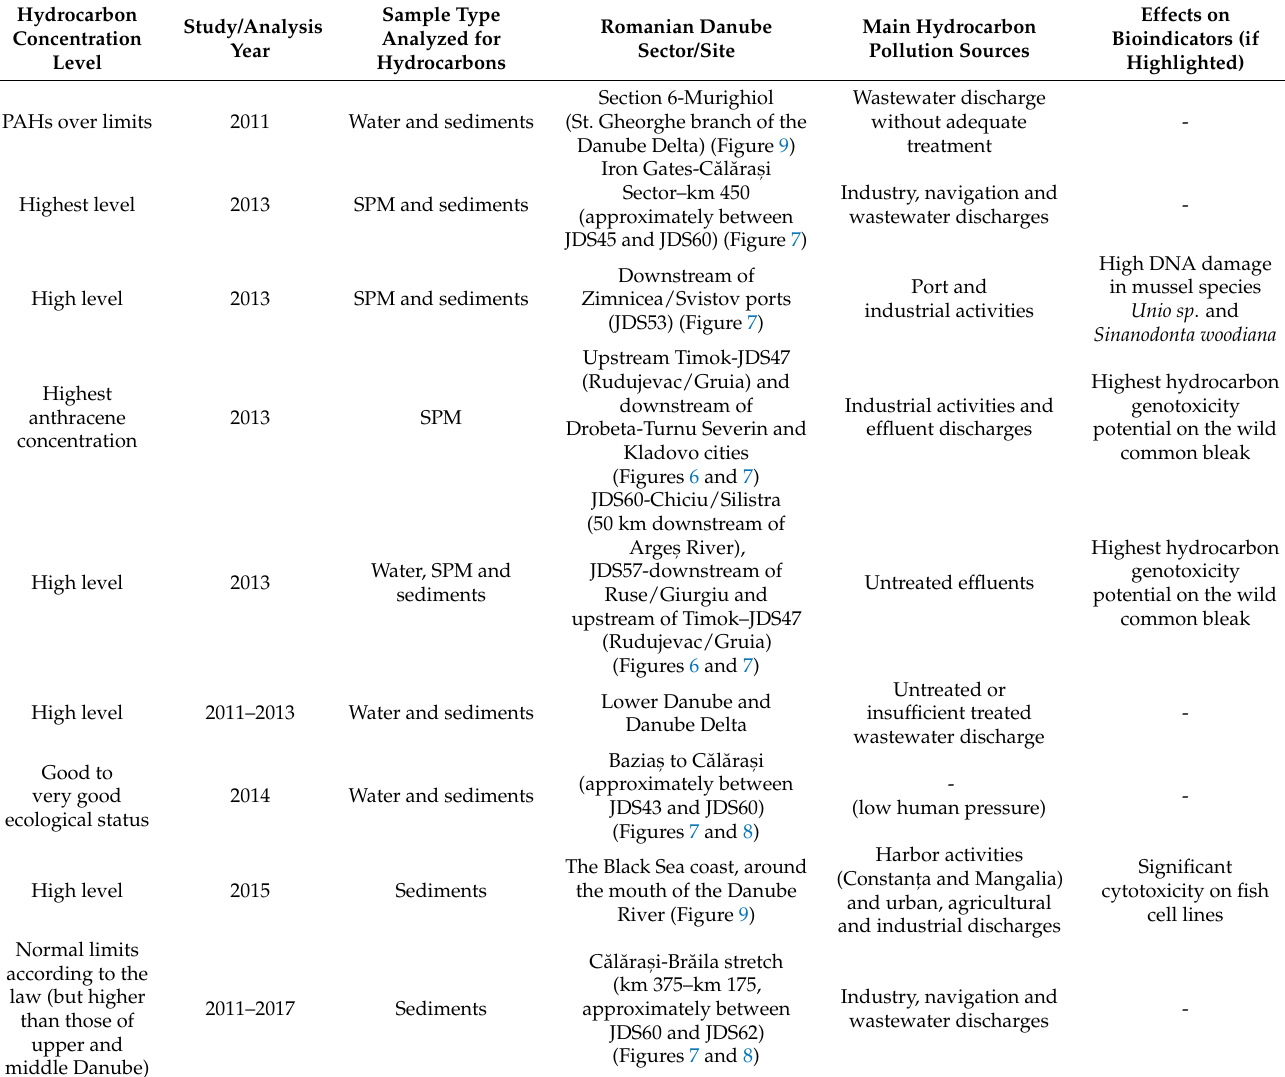
Table 4. The evolution of hydrocarbon concentration levels in the Romanian Danube, causes and effects on